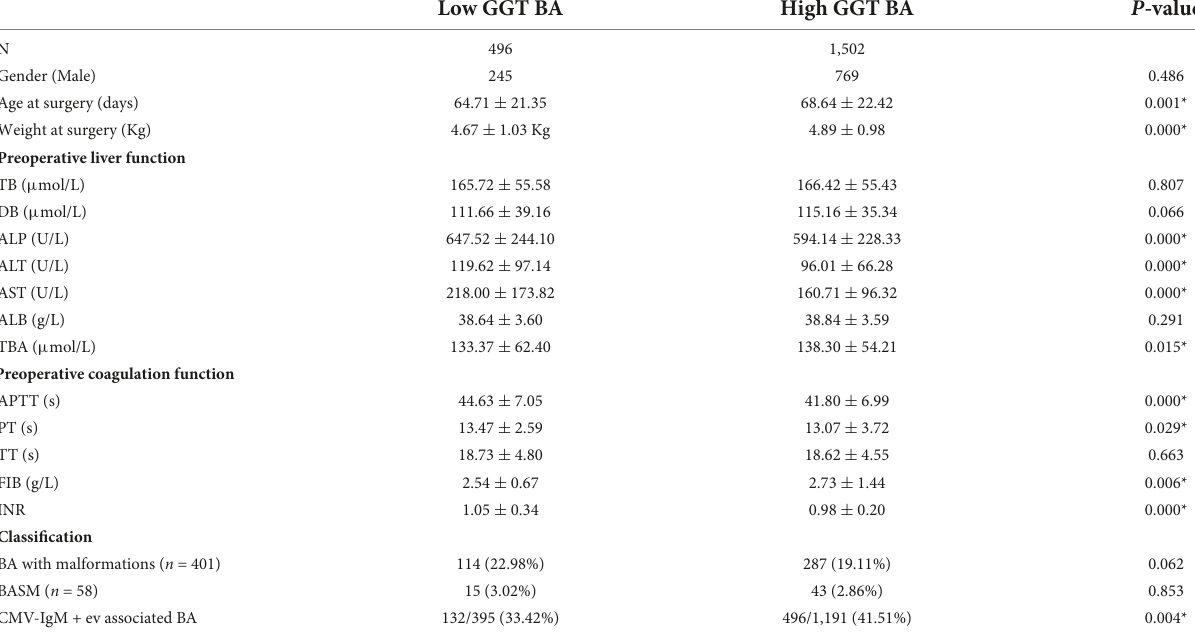
TABLE 1 Comparison of preoperative clinical indicators between low and high GGT